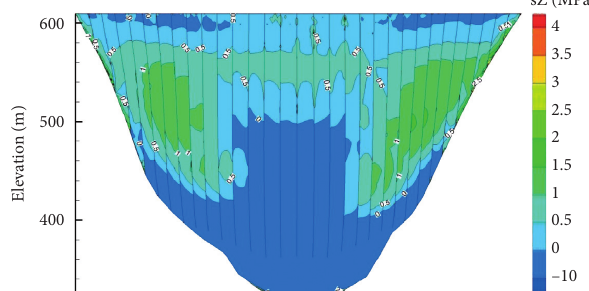
Figure 24: Envelope of maximum static and dynamic vertical stress distribution of downstream surface of the dam for no-slip condition.